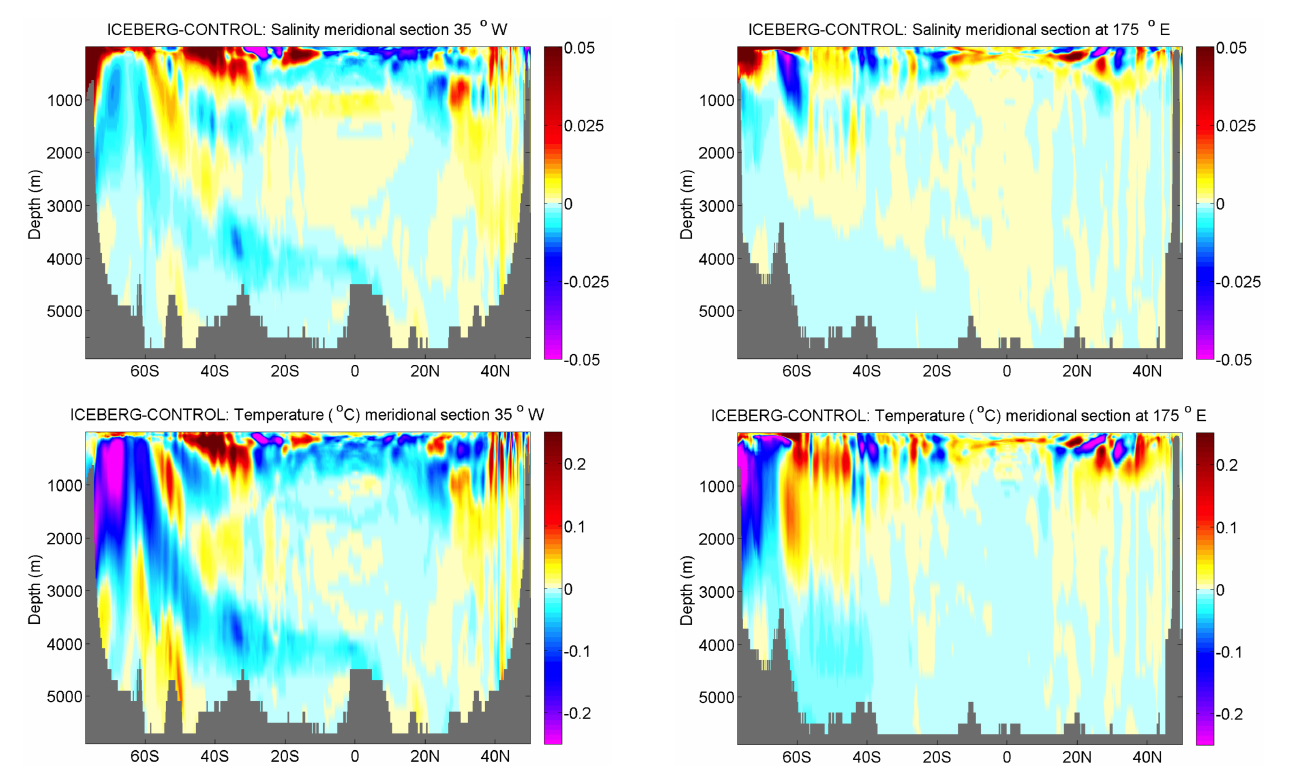
Figure 8. Meridional transect along 35 ◦ W, showing changes in salinity (upper panel) and temperature (lower panel), averaged over years 26–30.